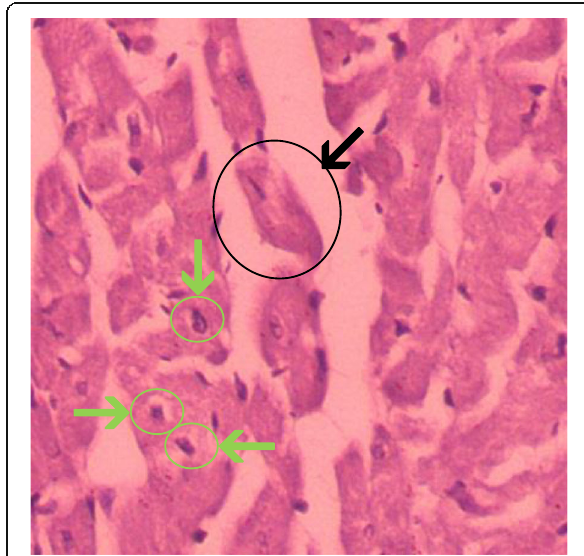
Fig. 1 Cardiac histology of normal control rat (Group 1) revealed regular arrangements of myofibrils with clear striation (pointed with black arrow) and normal and central distribution of nuclei (pointed with green arrows) (black dots on myofibrils); no disruption or inflammation in